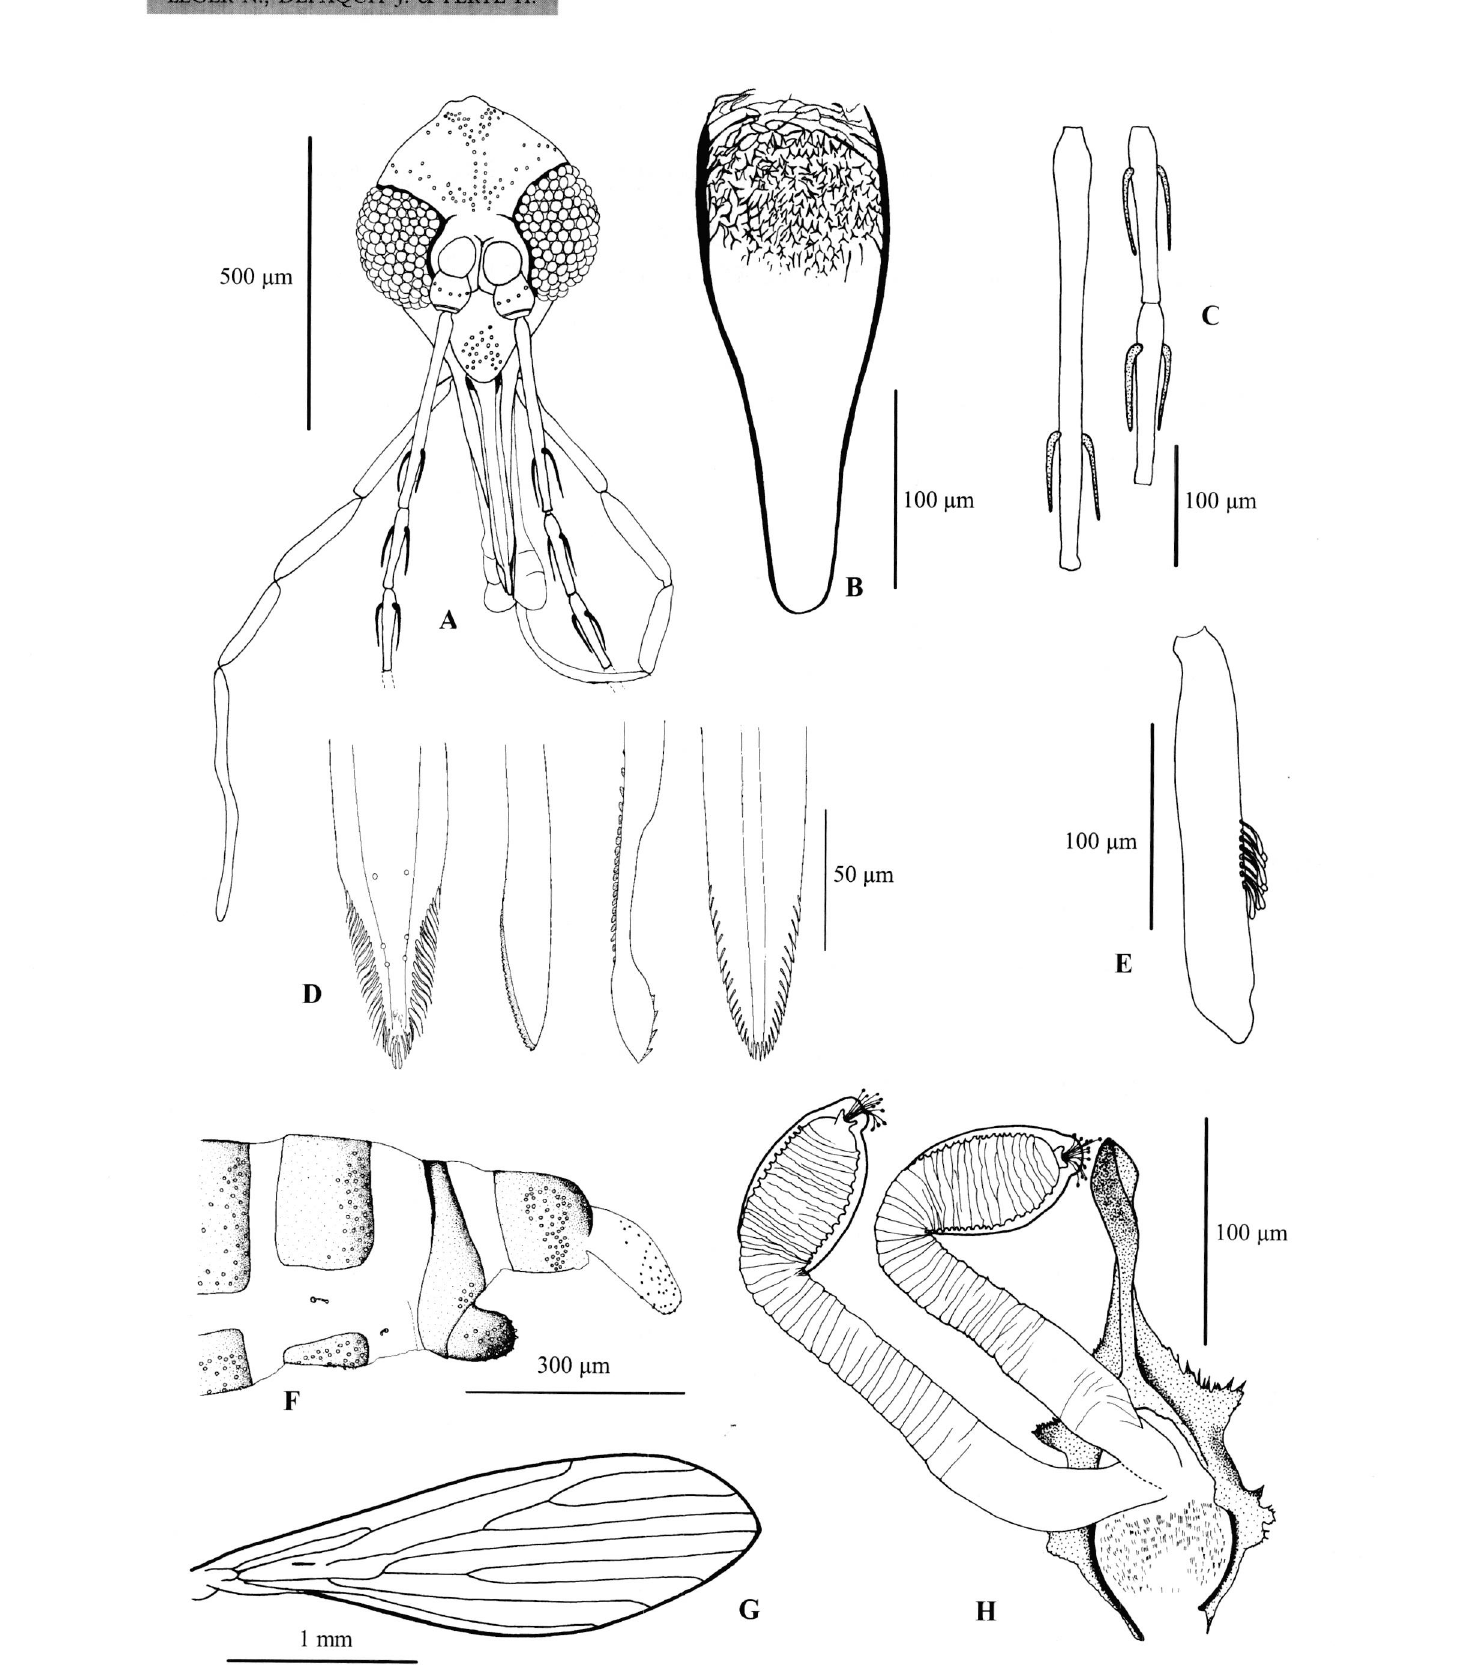
Fig. 1. - P. economidesi femelle. A : tête; B : pharynx; C : segments antennaires III, IV et V; D : pièces buccales (de gauche à droite : labre-épipharynx, mandibule, maxille et hypopharynx); E : troisième segment palpaire; F : extrémité distale de l'abdomen; G : aile; H : spermathèques, furca et armature de l'atrium